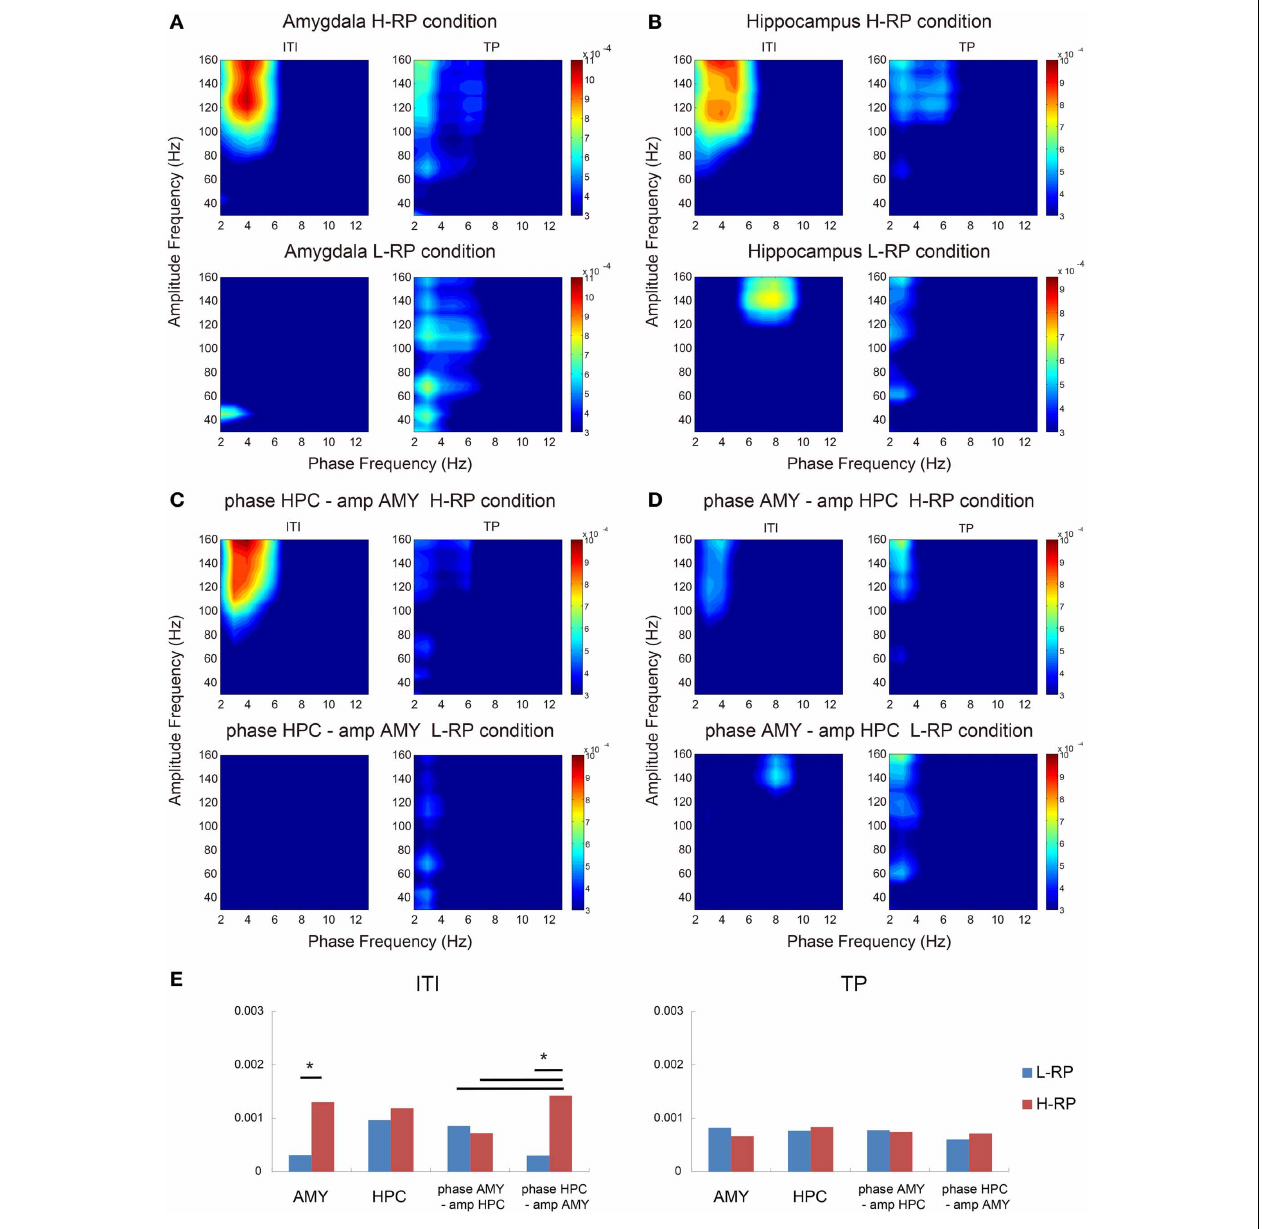
(B) Within the hippocampus. Same format as (A) . (C) Mean comodulograms in the hippocampal theta phase and the amygdala HFO amplitude. Same format as (A) . (D) Mean comodulograms in the amygdala theta phase and the hippocampal HFO amplitude. Same format as (A) . (E) Mean peak MIs of each comodulogram during ITIs (left graph) and the trial periods (right graph). Asterisks indicate significant differences of ∗ p < 0 .